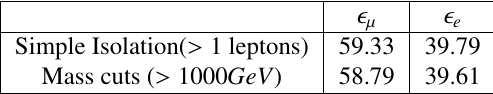
Table 1. Comparison of acceptance e ffi ciencies for electrons and muons for m Z